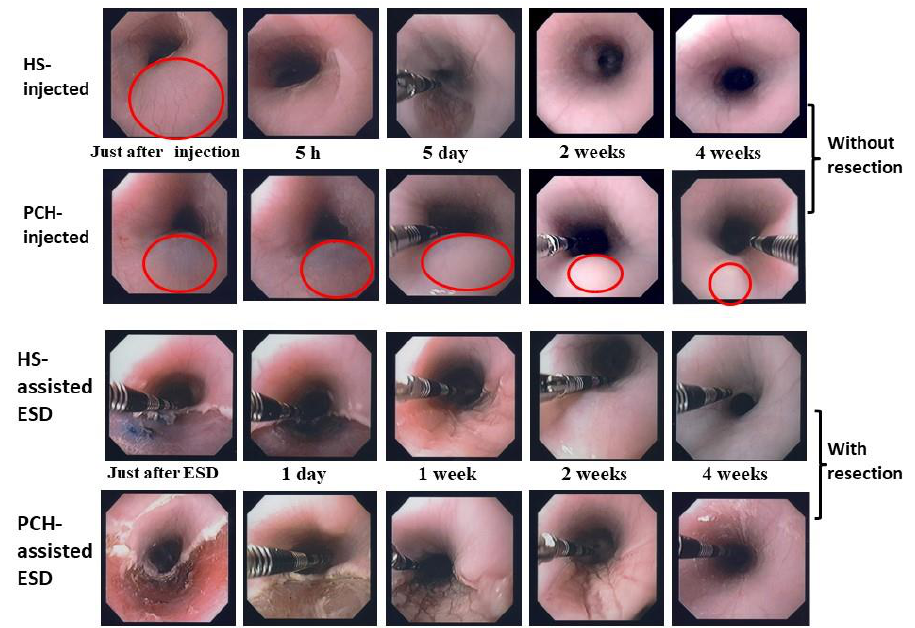
Figure 4. Changes in endoscopic appearance of hypertonic saline (HS)- or PCH-injected sites of pig esophagus (in live animals) without ( upper 2 rows ) and with ( lower 2 rows ) mucosal resection. Endoscopic changes of mucosal elevation shapes are shown at the following times after the injection of 2 mL HS or PCH: just after injection, and 5 h, 5 days, 2 weeks, and 4 weeks later. Endoscopic appearances are shown at the following times after HS- and PCH-assisted ESD: just after ESD, and 1 day, 1 week, 2 weeks, and 4 weeks later. Note the duration of elevation in the PCH-injected case (2nd row vs. 1st row; red circles represent centers of mucosal elevation). Reprinted from [7], Copyright 2012, with permission from Elsevier.